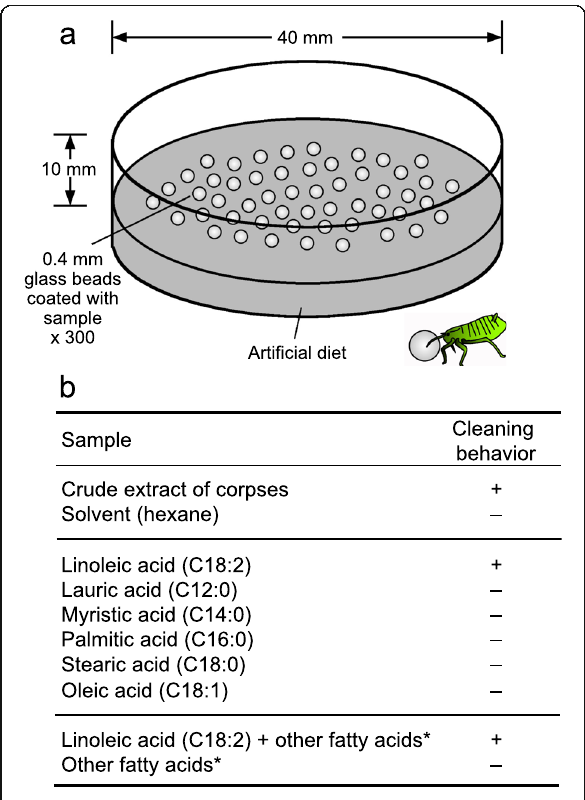
Fig. 4 Relative quantities of fatty acids on the body surface of dead old adults of T. styraci . ( a ) 0 day, ( b ) 1 day, and ( c ) 1 week after freeze-killing. The relative quantity of linoleic acid increased significantly after death, resulting in tenfold increase for the first one day (Steel ’ s multiple comparison test; P = 0.06) and twentyfold increase for one week after death (Steel ’ s multiple comparison test; P < 0.05). Sample sizes are shown in parentheses and standard errors are shown by vertical bars